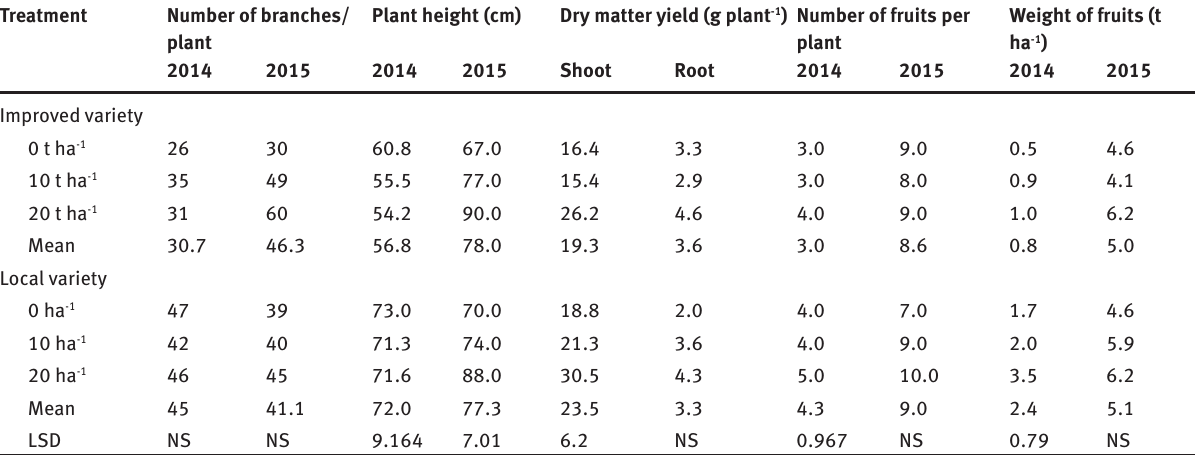
Table 9: Growth and yield characteristics of tomato varieties in response to field application of 3 rates of compost in 2014 and 2015 Treatment Number of